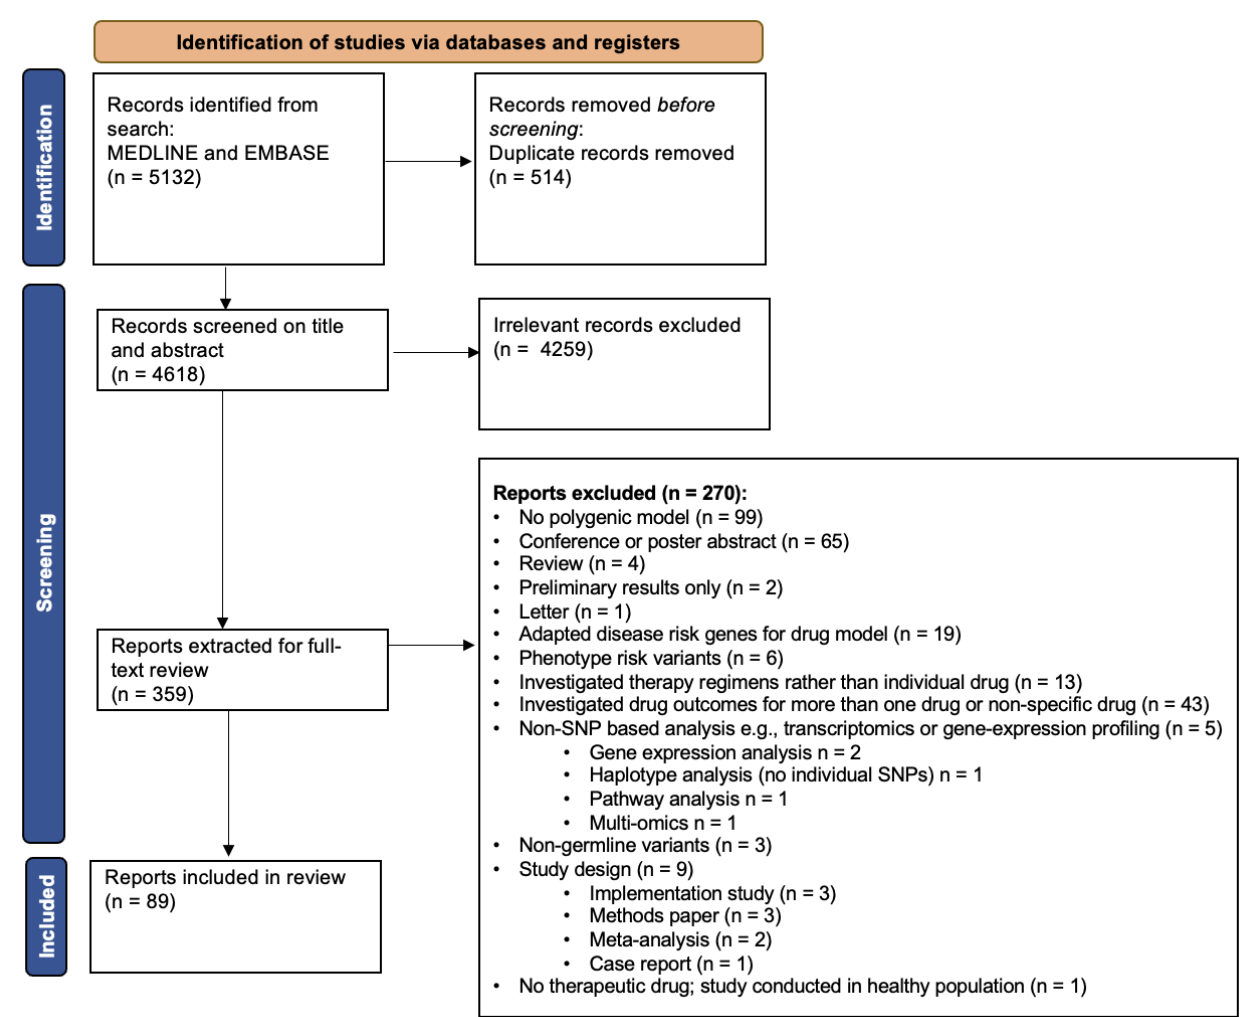
Figure 1. CONSORT flow diagram of articles screened and included in the final review. Flow chart adapted from an example in Page et al. (2021) [23].